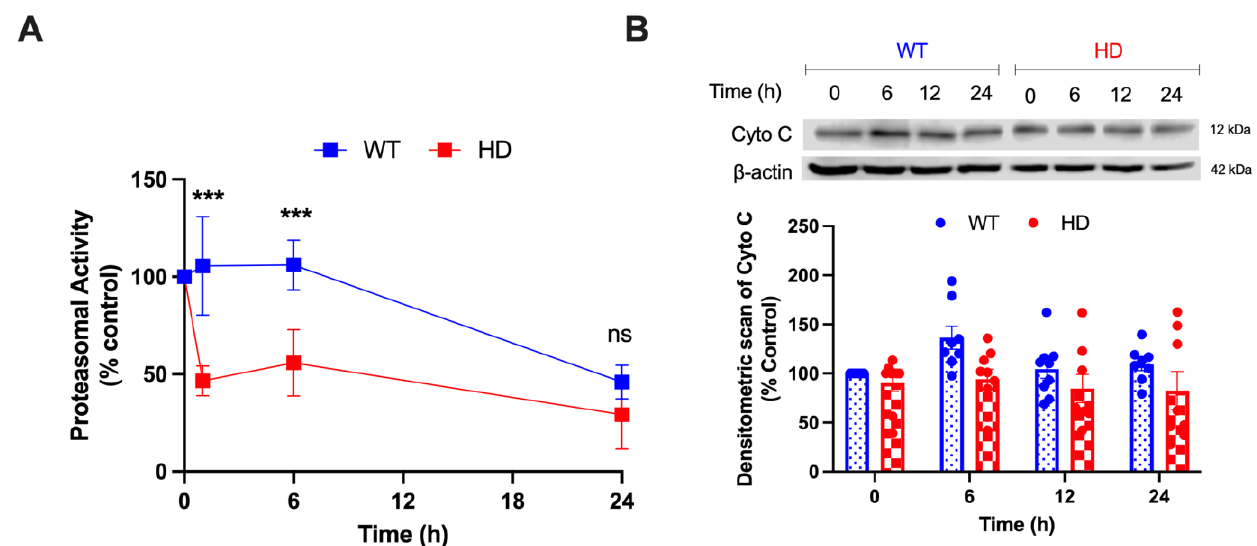
Figure 6. Effect of Cd exposure on UPS function and cytochrome C release. ( A ) Proteasomal activity was measured in WT and HD cells using a specific fluorogenic peptide substrate after exposure to 40 µM CdCl 2 at the indicated time points. Proteasomal activity was normalized by the protein concentration and expressed as the percentage of vehicle-treated control cells. Results are represented by the mean ± SEM from eight biological replicates (N = 8 ). Sidak’s multiple comparison test compared the effect of Cd on proteasomal activity between genotypes at the indicated time points (significant difference: *** p < 0.001). ( B ) Representative Western blot of endogenous protein levels of cytochrome C (Cyto. C) after exposure to 40 µM CdCl 2 for 0, 6, 12, and 24 h. Quantitative immunoblotting data is represented as percent expression relative to the respective control within each genotype. Results are represented by the mean ± SEM from four biological replicates (N = 4).